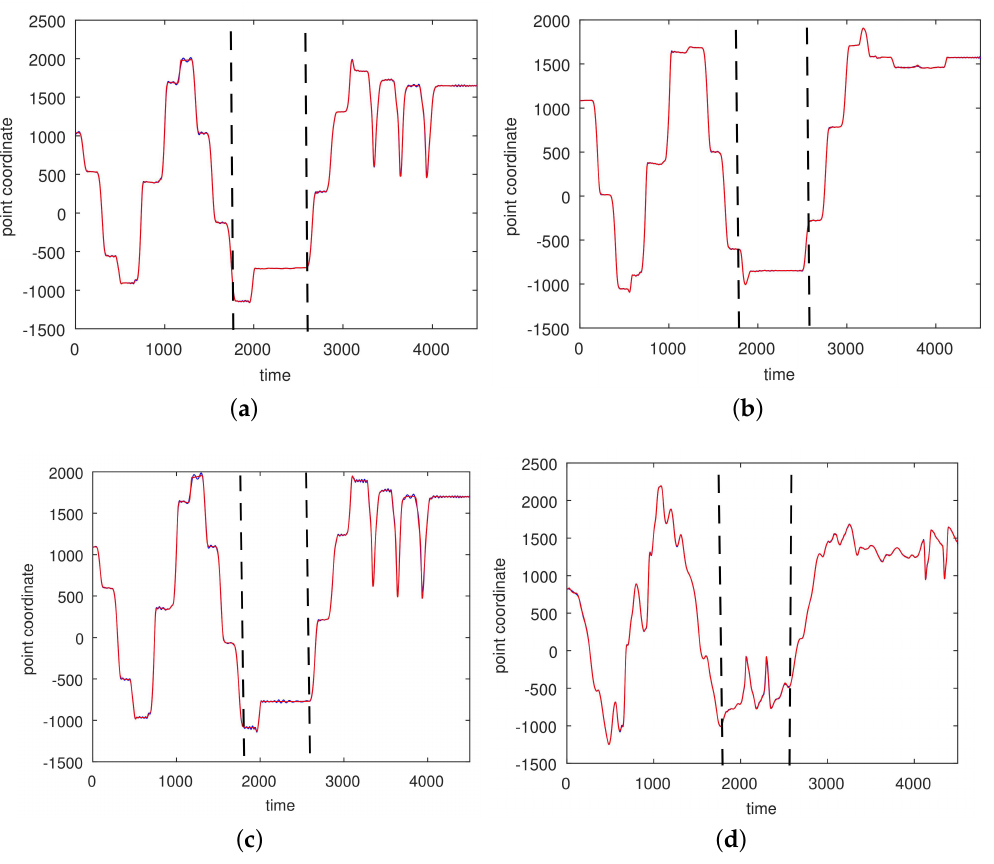
Figure 11. An approximation of y coordinates of a complicated motion (CMU 86 Trial 2; sampled at 120Hz) by an RBF-network with three centers and 100 satellites. The motion was segmented into three intervals [ 1,1800 ] , [ 1800,2500 ] , and [ 2500,4000 ] . ( a ) Right ankle; ( b ) Left ankle; ( c ) Right heel; ( d ) Left wrist, distal. The red curves show the experimentally observed coordinates and the blue curves represent their neural